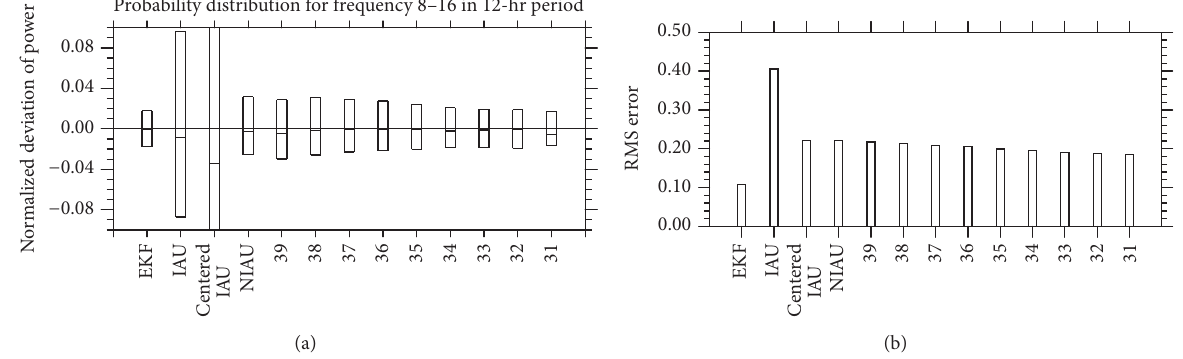
Figure 6: (a) Probability distribution function (PDF) of the deviation of the high-frequency (i.e., higher than 1.5 hours) power in each method (the EKF, the IAU, the NIAU, and the NIAU with the reconstructed TLM) from that of the true state, normalized by the high-frequency power oftruth.Thelowerandupperendofthebardenote15%and85%ofthecumulativedistributionfunction,respectively,withthemediandenoted as a line crossing the bar. The numbers in the 𝑥 -axis denote the number of SVs used to reconstruct the TLM for the calculation of the NIAU increment. (b) denotes the time average (from day 0 to day 10) RMSE in the EKF, the IAU, the NIAU, and the NIAU with the reconstructed